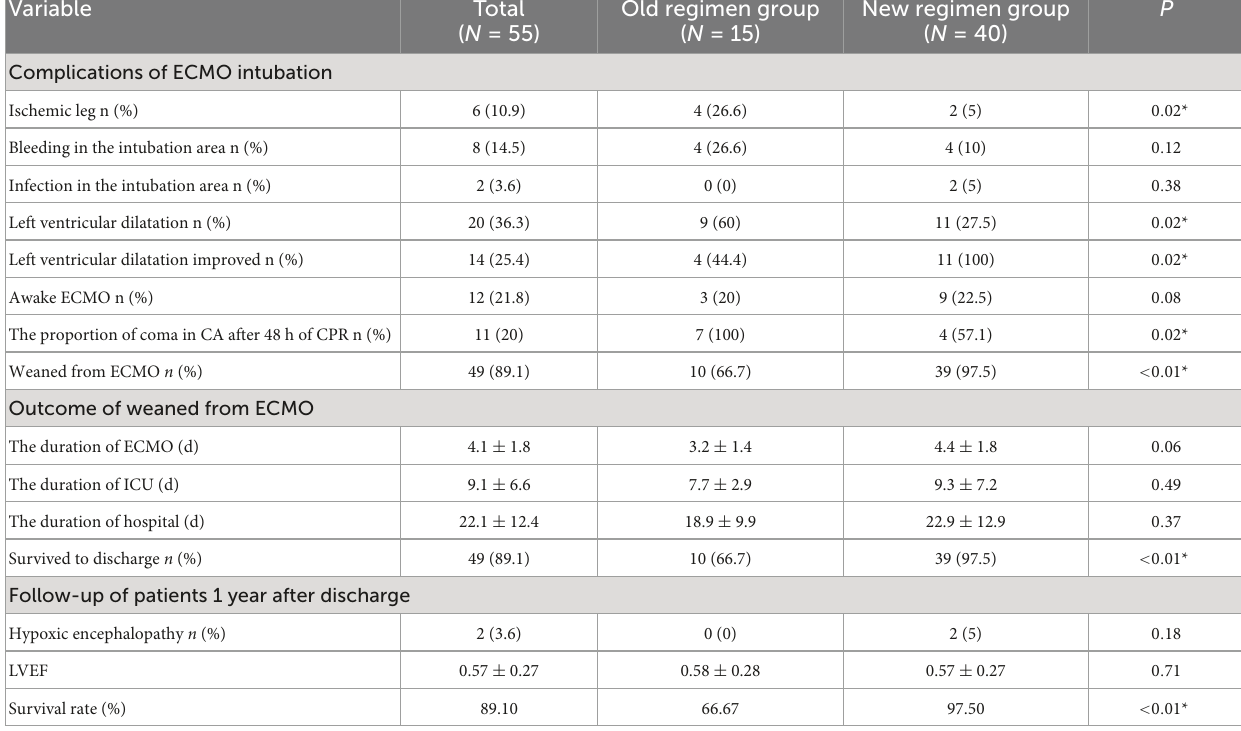
TABLE 4 Comparison of complications and therapeutic efficacy between the old and new regimen group with optimising the ECMO treatment regimen. Variable Total